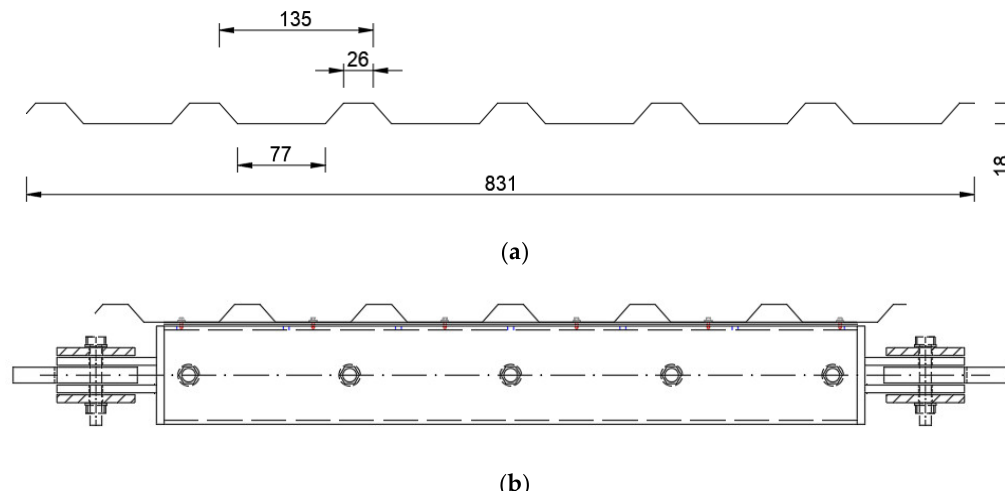
Figure 3. Specimens’ details: ( a ) trapezoidal sheeting geometry [mm]; ( b ) trapezoidal sheeting fastened to the permanent frame (scheme of the fasteners).